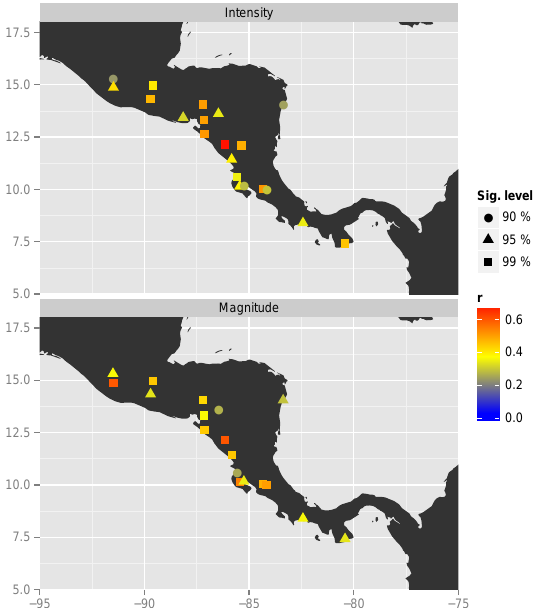
Figure 8. Pearson correlation of the CCA models with the time se- ries of intensity (top) and magnitude (bottom) of